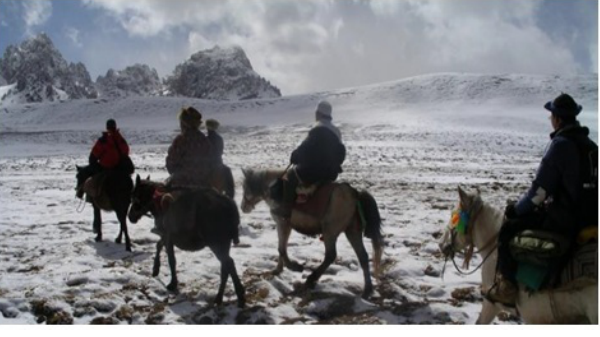
Fig. 7 . Community patrols by Cuochi villagers. (Photo by